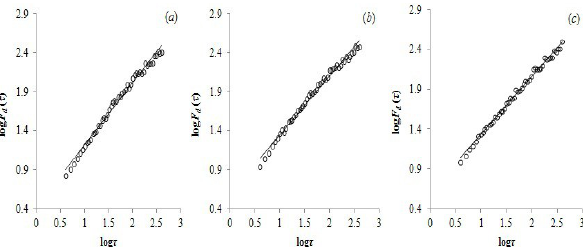
Fig. 6. Log-log plot (10-base logarithms) of the root-mean-square fluctuation function F d (τ) versus time interval τ (in months) for the detrended monthly mean LSAT anomalies dataset (a) globally with the best fit equation ( y = 0 . 80 x + 0 . 41 with R 2 = 0 . 99), (b) over the NH with the best fit equation ( y = 0 . 75 x + 0 . 60 with R 2 = 0 . 99), and (c) over the SH with the best fit equation ( y = 0 . 73 x + 0 . 60 with R 2 = 0 . 99). Note: By removing the cross-over point that cor- responds to around 50 months, the DFA exponent in (a) slightly decreases (=0.78 ± 0.01) and in (b) remains the